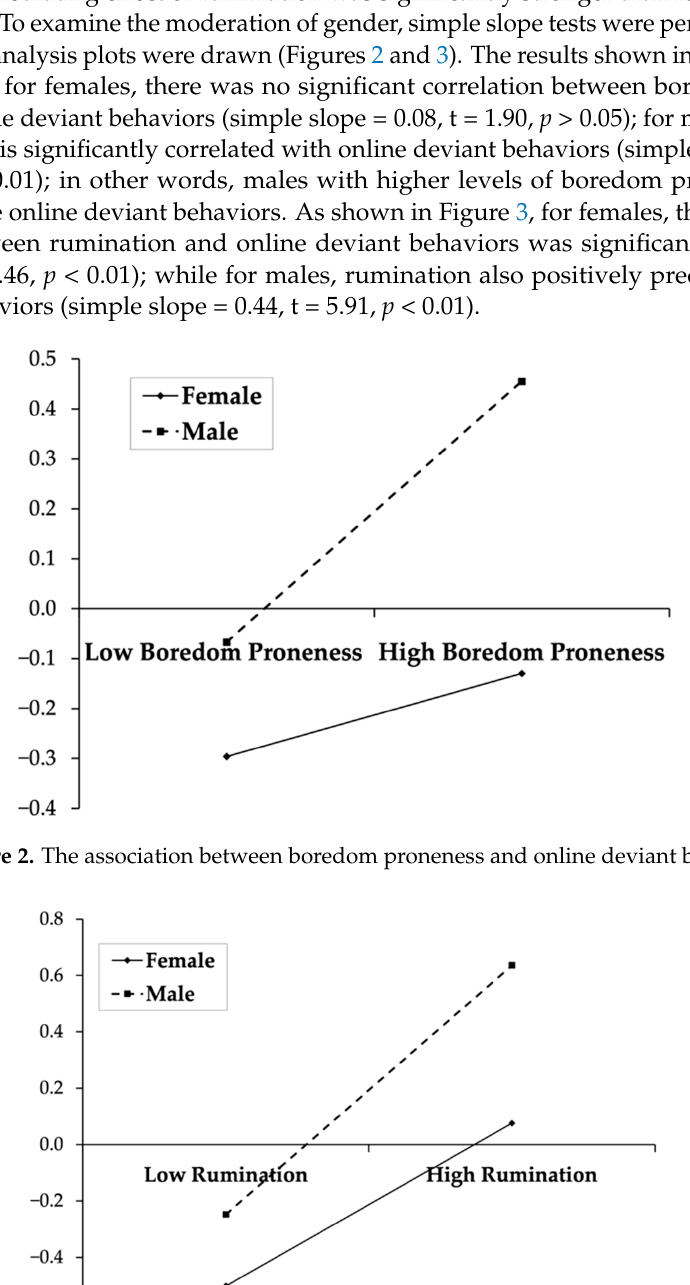
Figure 1. The moderated mediation model.